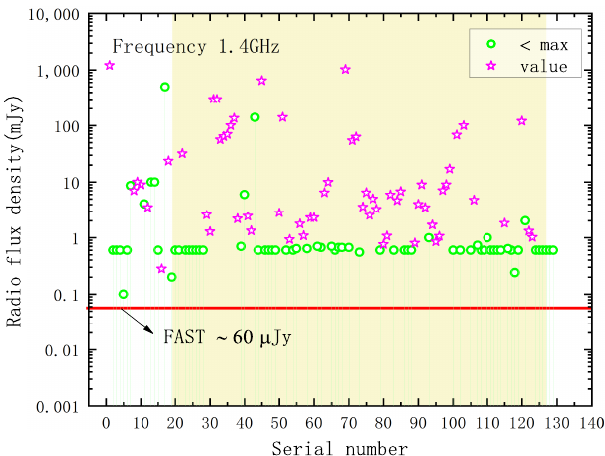
Figure 9. Distribution of the radio flux of radio stars in the 1.4 GHz frequency; the red line is the detection limit of the FAST